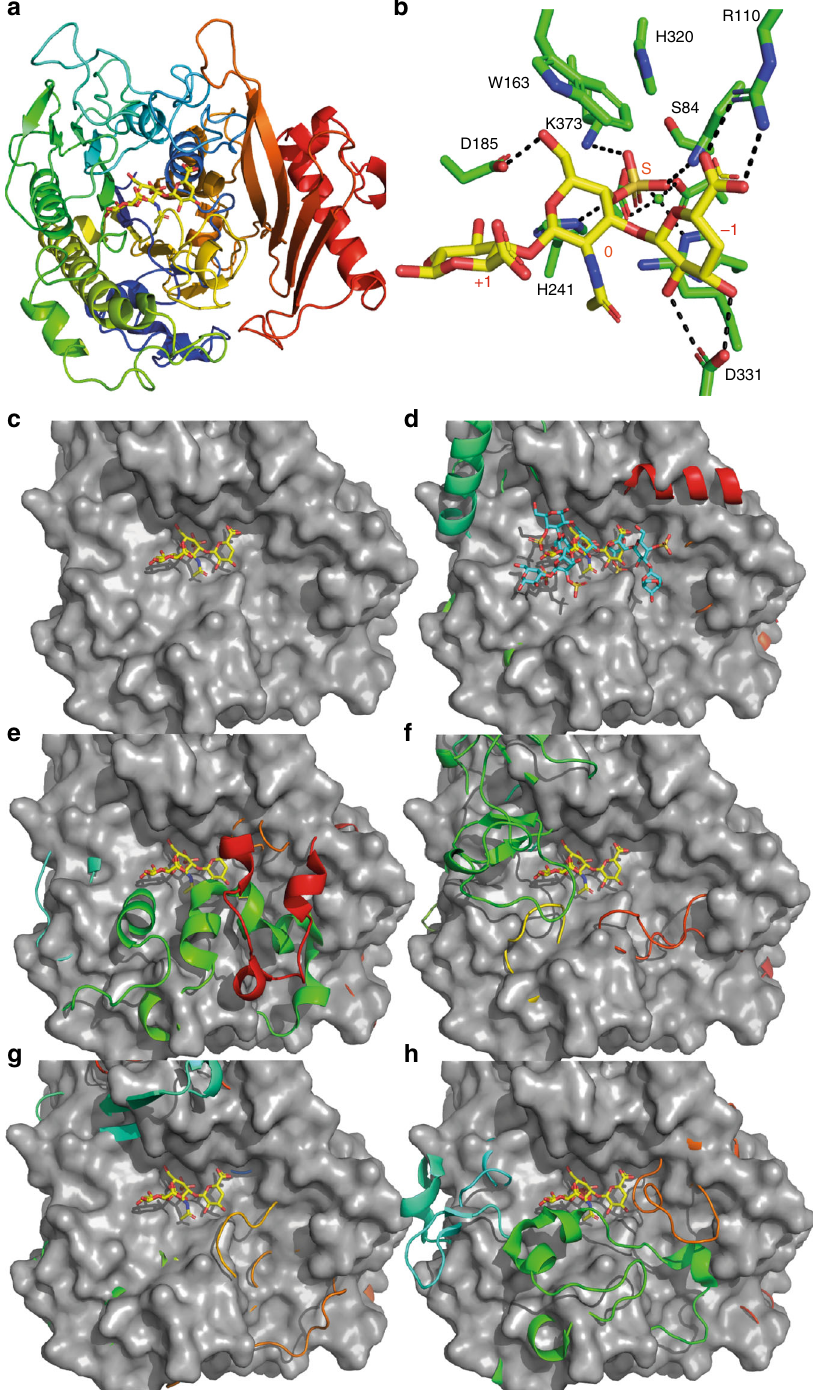
Fig. 4 Structural depictions of BT3349-S1_27 4S and its comparison with other endo and exo sulfatases. a Cartoon representation of BT3349-S1_27 4S-sulf ramped blue to red from its N- to C-terminus; b stick representation of binding site interactions with the protein in green and the bound trisaccharide yellow; c surface representation of BT3349-S1_27 4S-sulf showing how the + 1 and − 1 ends of the trisaccharide are free to be extended; d overlays of surface representations of BT3349-S1_27 4S-sulf and a cartoon of the marine endo 4S ι -carrageenan sulfatase (PsS1_19A). CS and ι -carrageenan oligosaccharides are shown in yellow and cyan, respectively. e Overlay of a surface of BT3349-S1_27 4S-sulf with a cartoon of the exo-sulfatase BT1596-S1_9 2S-sulf . f Overlay of a surface of BT3349-S1_27 4S-sulf with a cartoon of the exo-sulfatase BT3333-S1_15 6S-sulf . g Overlay of a surface of BT3349-S1_27 4S-sulf with a cartoon of the human exo-sulfatase 1FSU 4S-sulf . h Overlay of a surface of BT3349-S1_27 4S-sulf with a cartoon of the human exo-sulfatase 5FQL 2S-sulf . All cartoon representations are ramped blue to red from their N- to